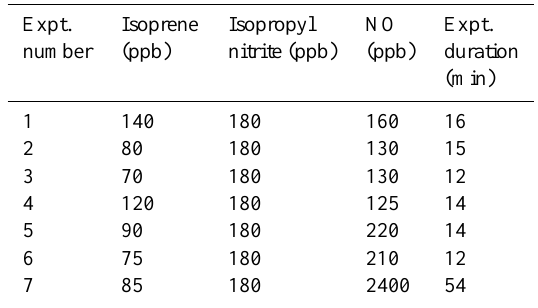
Table 2. Initial conditions for IN yield experiments.